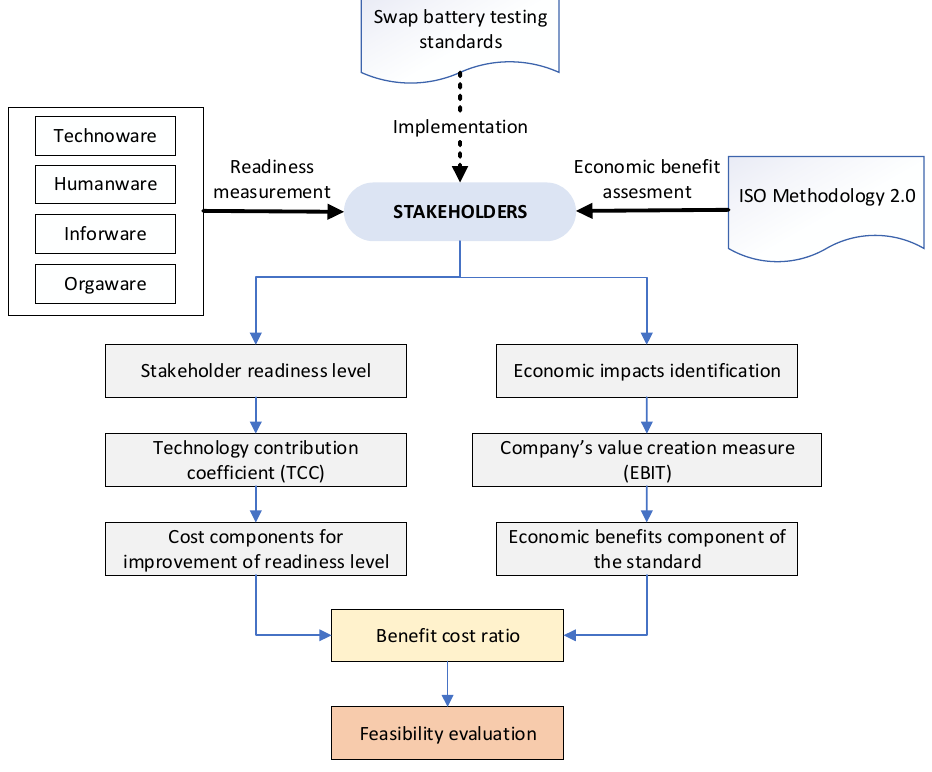
Figure 1. Model implementation framework.